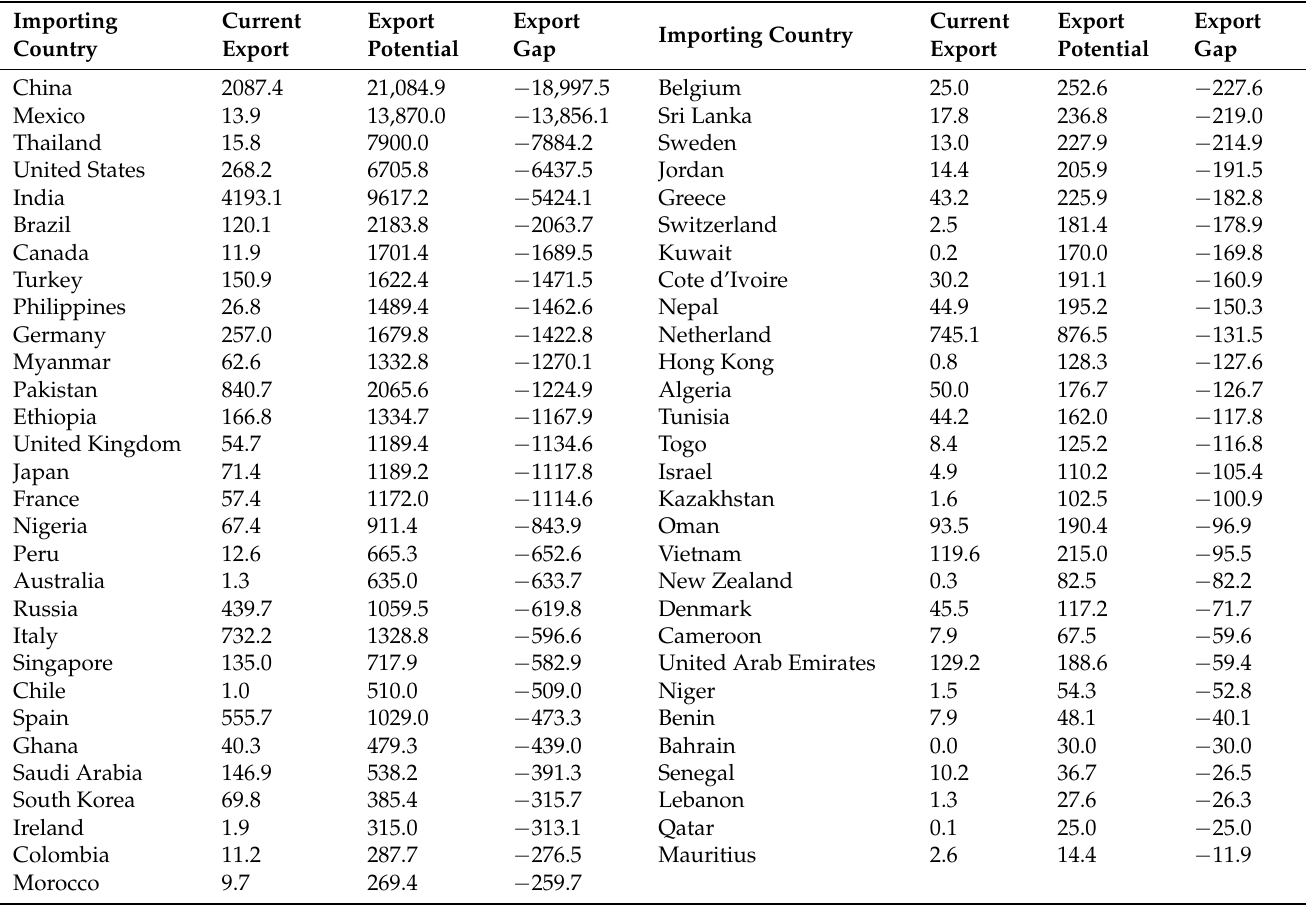
Table 7. Indonesia Palm Oil Export Potential and Export Gap, average million USD